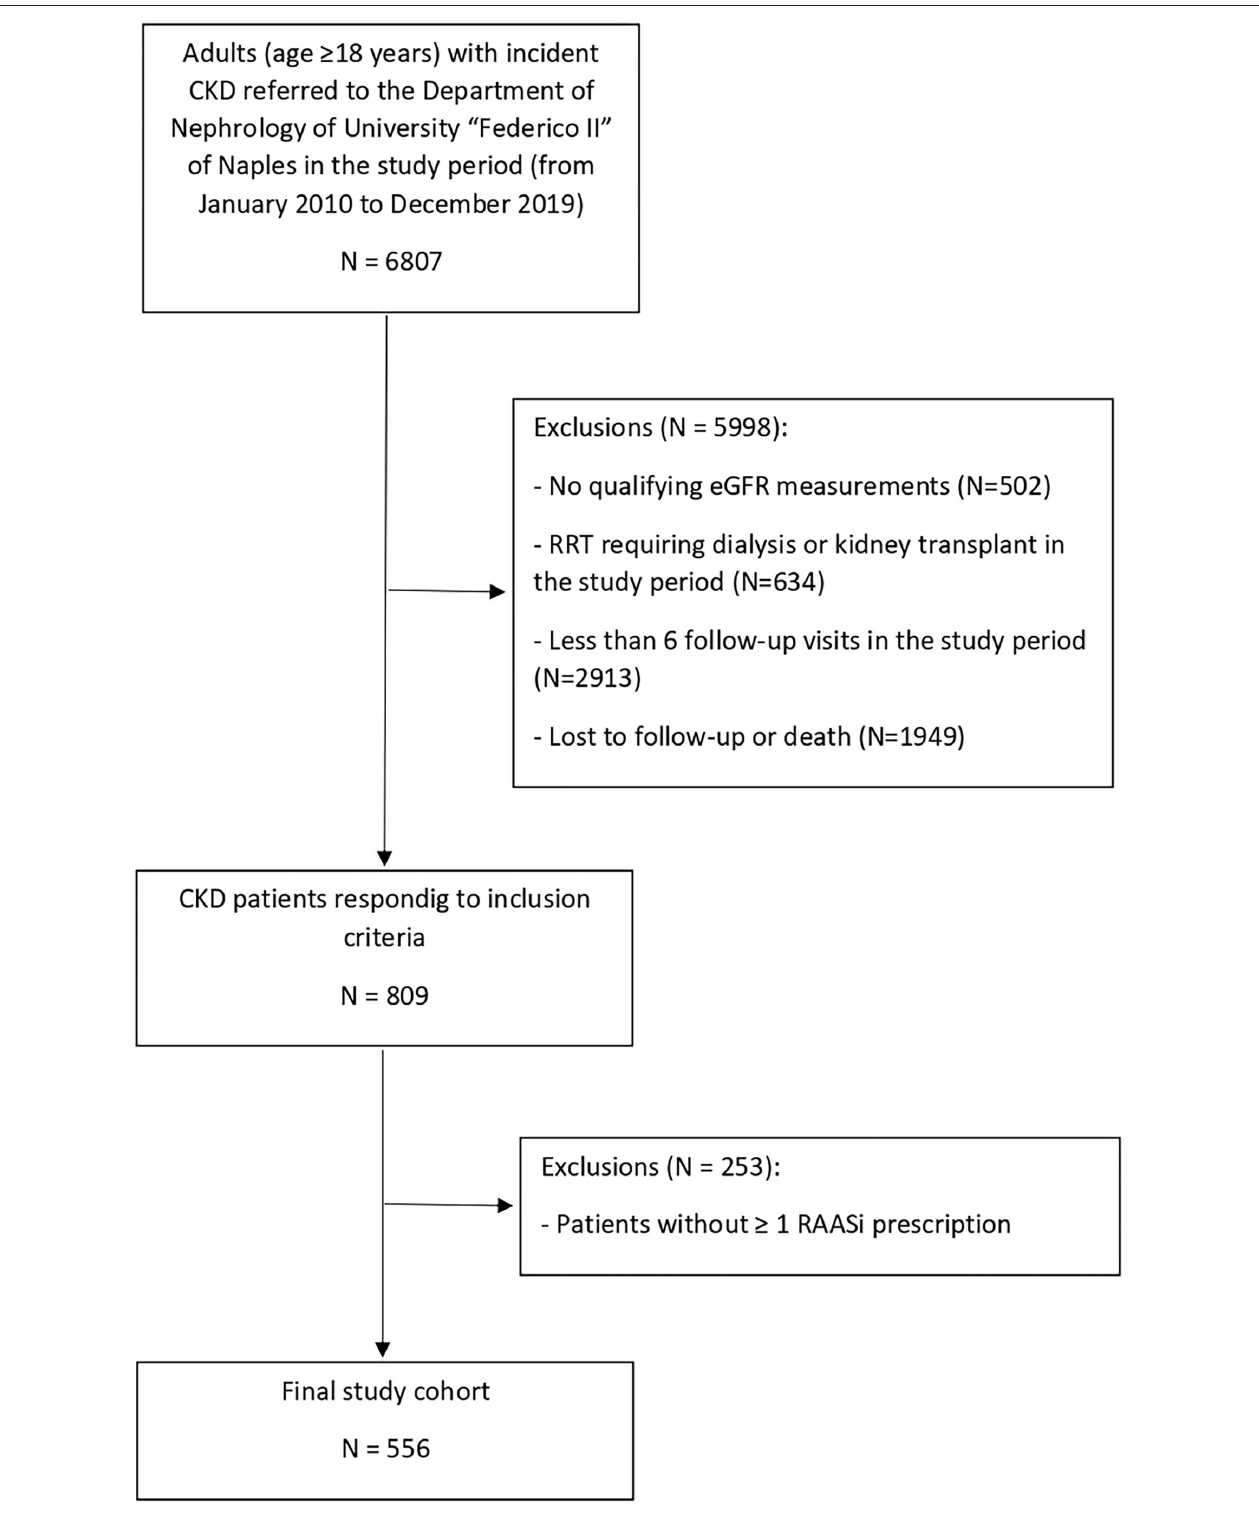
FIGURE 1 | Identification of study cohort. CKD, chronic kidney disease; eGFR, estimated glomerular filtration rate; RAASi, renin-angiotensin-aldosteron system inhibitors; RRT, renal replacement therapy.